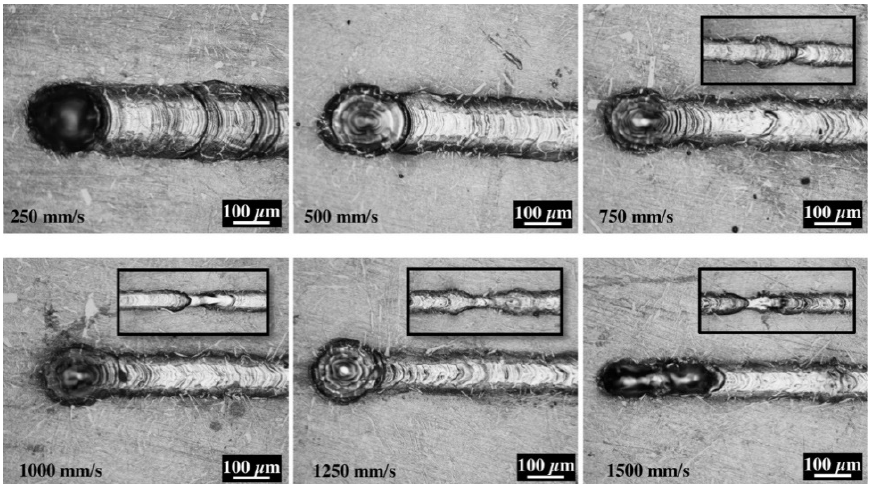
Figure 36. Variation in the shape of the fusion line of AlSi10Mg SLM single tracks as a function of increasing laser scan speed [167]. Copyright 2015. Adapted with permission from Elsevier Science